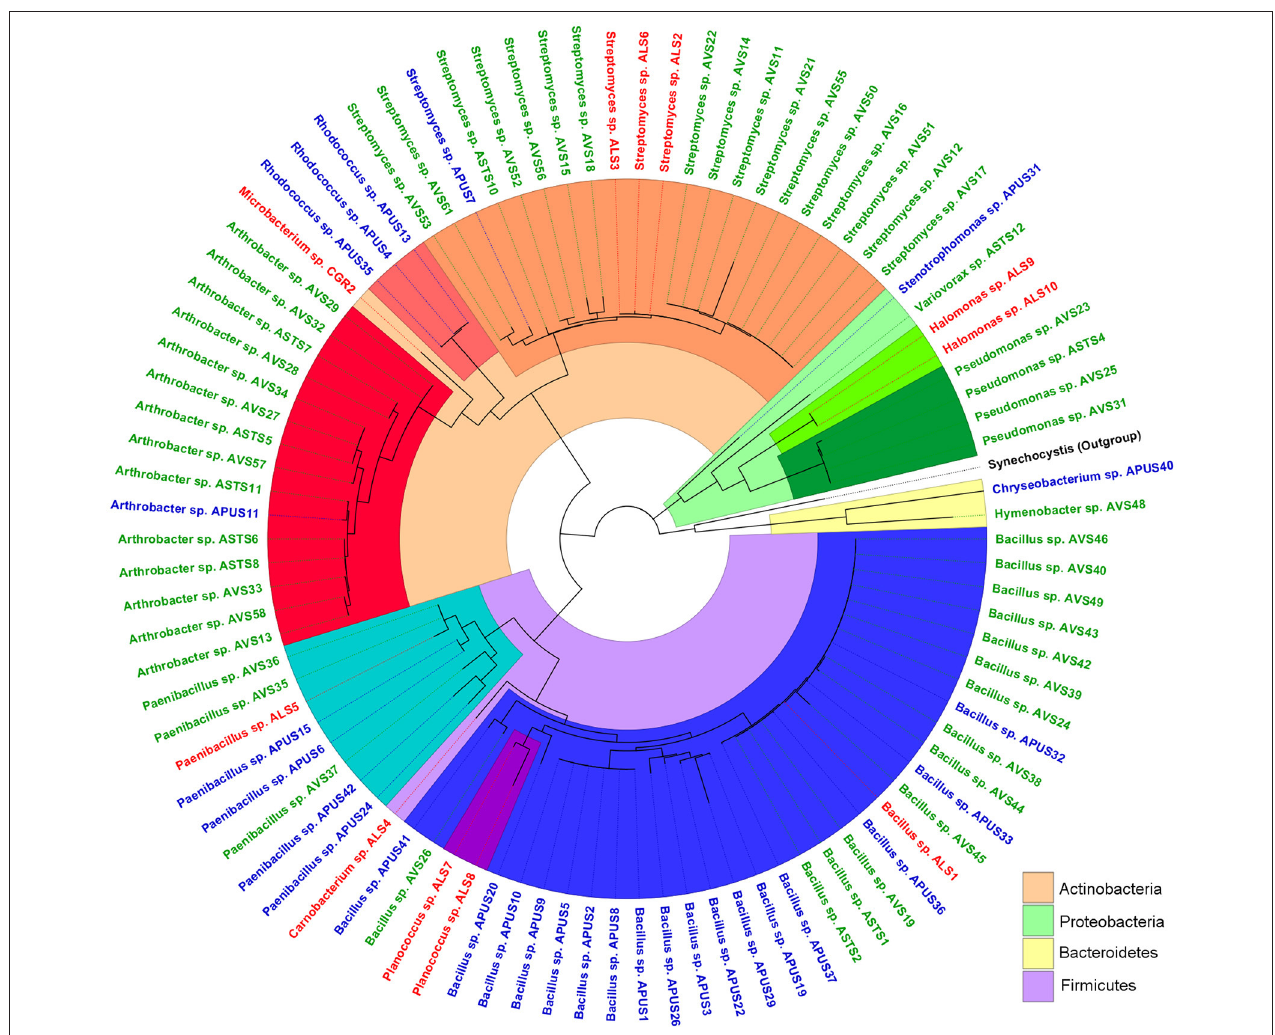
FIGURE 1 | Phylogenetic tree of the bacterial isolates recovered from the highlands of the Atacama Desert. Colors from the inner circle represent the phyla and genera of the bacterial isolates: Proteobacteria (green color range), Firmicutes (blue color range), Actinobacteria (orange color range), and Bacteroidetes (yellow); label color represents the isolation site: Lejía Lake (red), TLT1 (green), and TLT8 (blue). Synechocystis was used as outgroup and marked in black. The tree was constructed using the MEGA7 software and edited with the FigTree